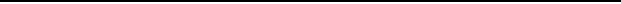
Fig. 7 Prdm16 is a co-activator of Hlx and their thermogenic functions are inter-dependent. a mRNA levels of iWAT injected with overexpression adenoviruses ( n = 4 mice per group). b iWAT isolated from mice in ( a ) was immunostained with a Tom20 antibody. Green , Tom20; blue , DAPI. Scale bar , 200 µ m. c Flag-Hlx and HA-Prdm16 or HA-Pgc1 α were transfected into HEK293 cells. Extracts were immunoblotted with an HA antibody after immunoprecipitation with a Flag antibody. d Cell extracts of brown adipocytes were immunoprecipitated with an antibody against Hlx and immunoblotted with an antibody against Prdm16. e Transcriptional activity of Gal4-Hlx fusion protein on Gal4 promoter in the presence of increased amounts of Prdm16 ( n = 3). f Transcriptional activity of Hlx on the 3.1-kb Ucp1 promoter in the presence of Prdm16 ( n = 3). g Top , Cyan bars depict Prdm16 peaks containing putative Hlx-binding motifs at the promoters of indicated genes, and the positions (in kb) of these peaks relative to transcription start sites are indicated. Black bars depict the location of control sites used in ChIP-qPCR assay. Middle , ChIP-qPCR analysis of Hlx association with the corresponding Prdm16 peaks in brown adipocytes with or without Hlx knockdown. Data represent average of two experiments. Bottom , ChIP-qPCR analysis of Prdm16 association with the corresponding Prdm16 peaks in brown adipocytes with or without Hlx knockdown. Data represent average of two experiments. h Brown preadipocytes were infected with Prdm16 shRNA lentivirus and differentiated. Mature adipocytes were infected with Hlx expression adenovirus, and gene expression was analyzed ( n = 3). i Mature adipocytes generated as in ( h ) were stained with MitoTracker Red. Scale bar , 200 µ m. j Brown preadipocytes infected with Hlx shRNA lentivirus were differentiated and infected with Prdm16 adenoviruses at day 2 and day 4. Gene expression was analyzed at day 6 ( n = 3). k Mature adipocytes generated as in ( j ) were stained with MitoTracker Red. Scale bar , 200 µ m. l Mature brown adipocytes generated as in ( j ) were measured for oxygen consumption without or with Oligomycin A (1 µ M ) ( n = 3). All images shown are representative of three experiments. All error bars represent s.e.m. Two-tailed unpaired Student ’ s t-test was performed. * p < 0.05; ** p < 0.01; *** p <